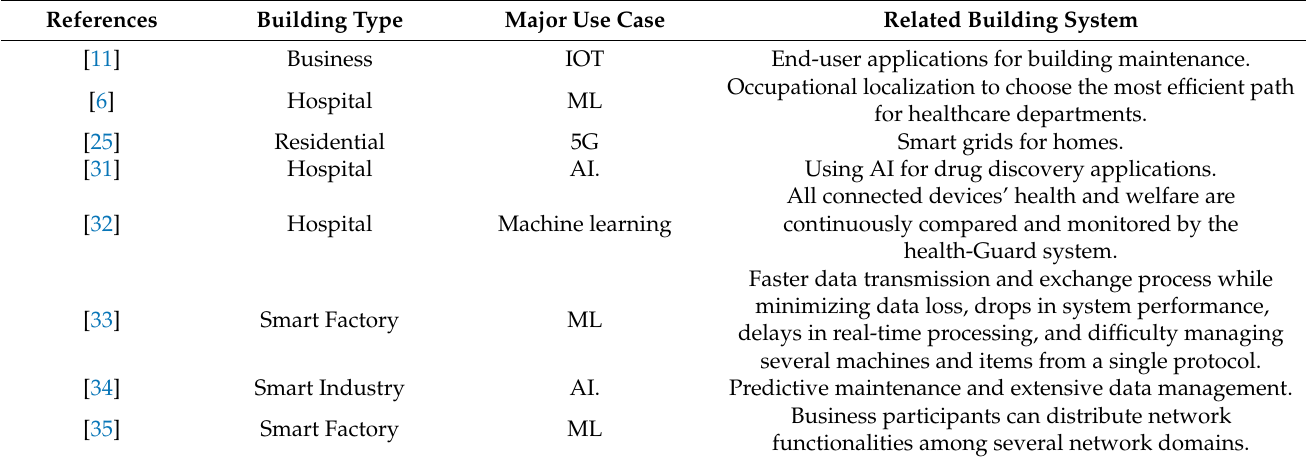
Table 1. The major cases of 5G applications in smart buildings and